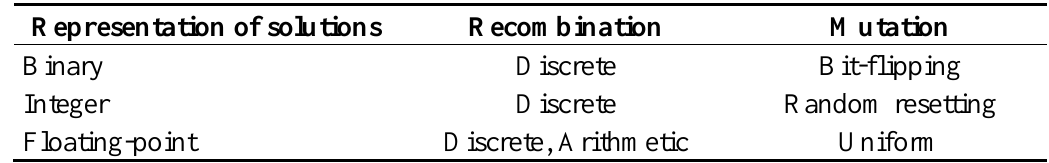
Table 1. Common recombination and mutation noperators applied for binary, integer, and floating-point representations.